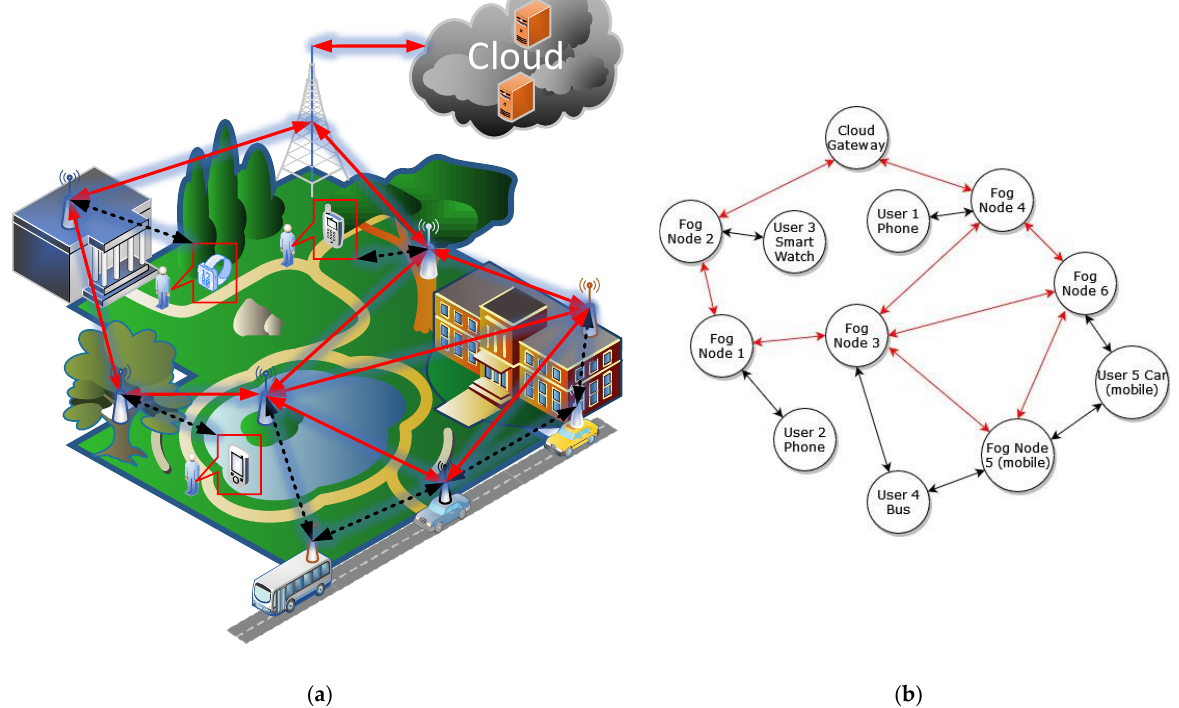
Figure 1. A heterogeneous ad hoc fog network architecture with mobile user devices and static and mobile fog nodes: ( a ) a conceptual model of the fog architecture of the smart campus of a university. The arrows represent the data routing paths between the fog nodes, user end-devices, and cloud servers. ( b ) A graph representation of the fog architecture. The graph nodes represent the fog nodes and user devices, and the graph edges represent the communication paths.